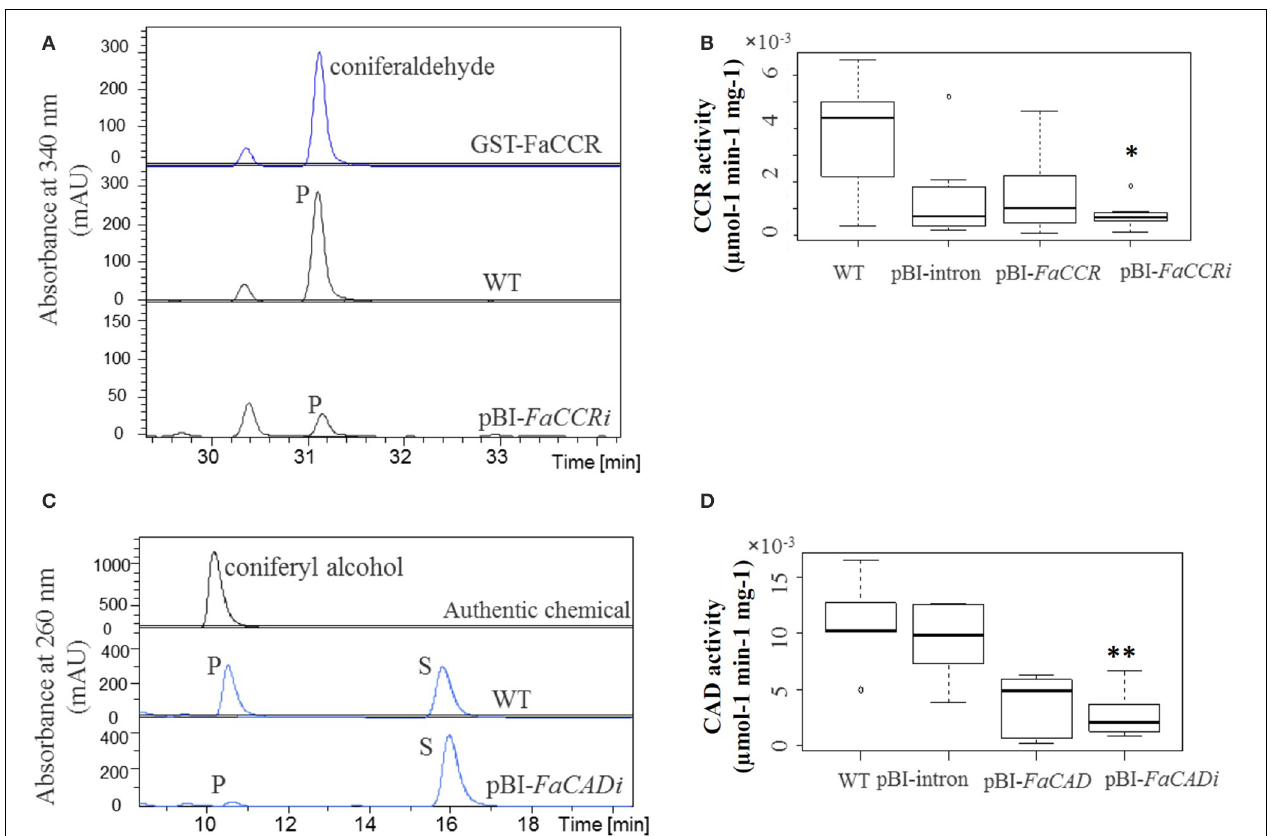
FIGURE 8 | CCR (A,B) and CAD (C,D) specific activity in wild-type and agroinfiltrated fruits. (A) Coniferaldehyde (P; products) formed in the reactions was quantified at 340nm. (B) Untreated fruits (WT), control fruits (pBI-intron), pBI- FaCCR , and pBI- FaCCRi ; each group n = 7. (C) Coniferyl alcohol formed in the reactions (P = coniferyl alcohol; S = coniferaldehyde) was quantified at 260nm. (D) WT, pBI-intron, pBI- FaCAD ,